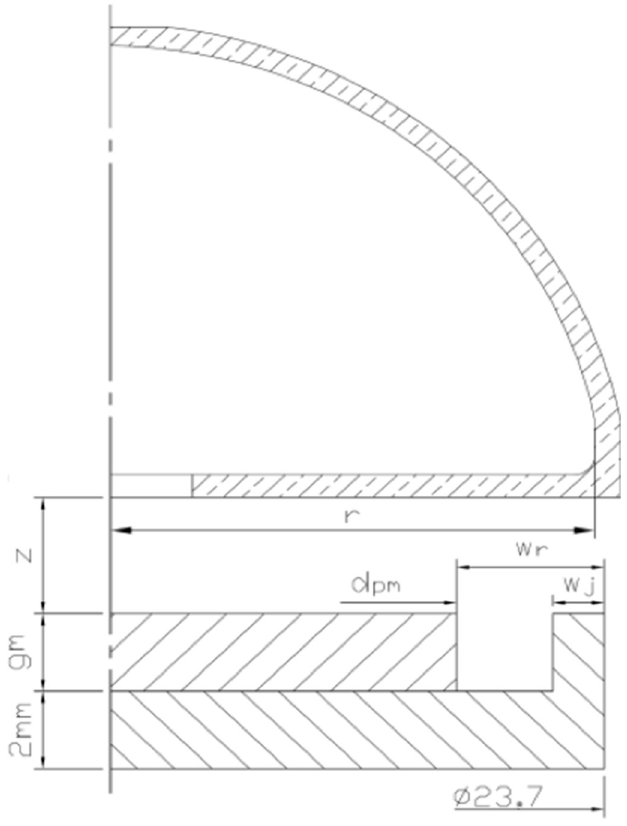
Figure 5. Graphical explanation of the geometry factors of the analyzed configuration and the cushion. Defined factors dpm , wr , wj, and distances z from the magnetic field exciter to the base of the cushion.